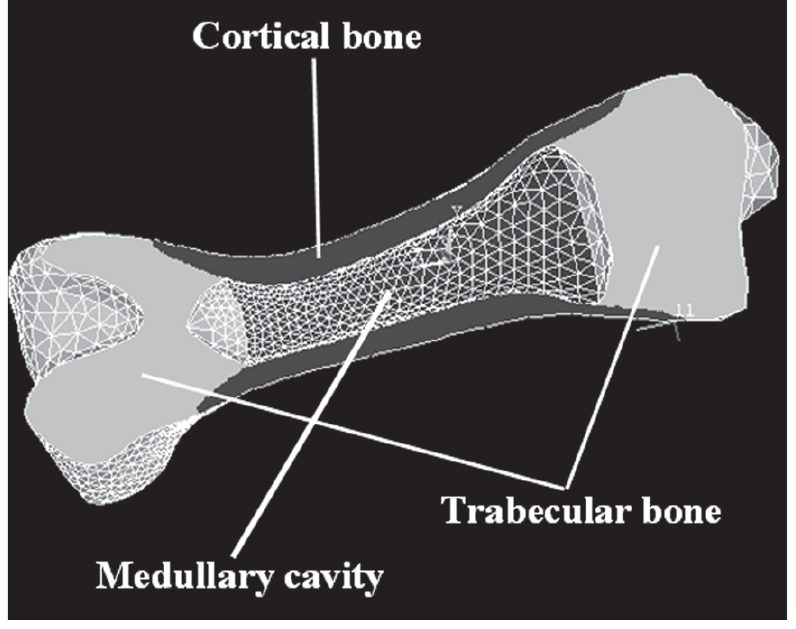
Fig. 3. Longitudinal section of humerus